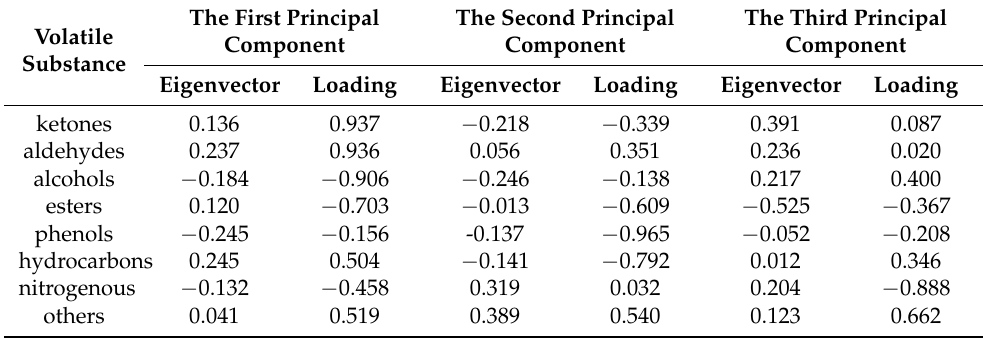
Table 4. Eigenvectors and loading matrix of first three principal components.